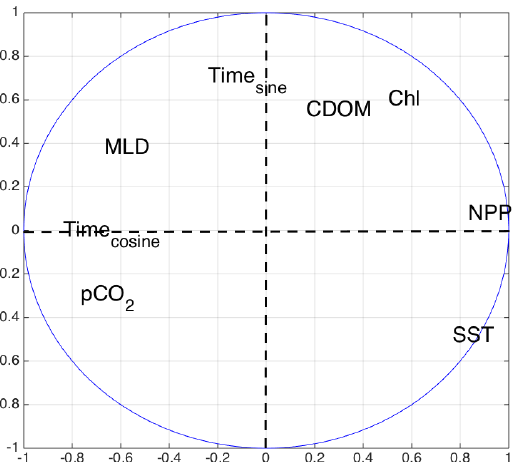
Figure 3. Correlation scatter plot with the representation of param- eters on axes 1 and 2. The first component plane contains 62% of the total variance of the system under study, and all parameters are close to the exterior of the circle, indicating that they are all impor- tant in order to invert the p CO2. Table 1. Percent of variance explained by each axis of the PCA. Axis number 1 2 3 4 5 6 Percent of variance 42